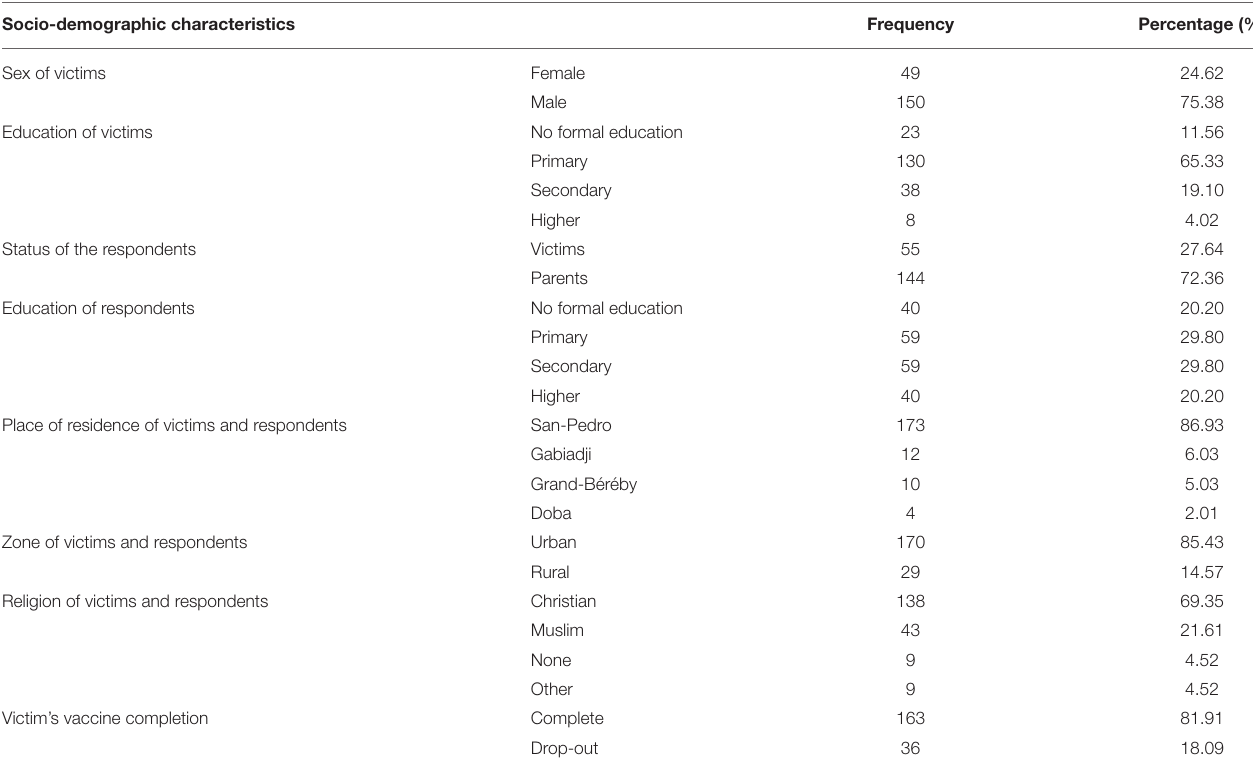
TABLE 1 | Summary of the socio-demographic characteristics of victims only and of all respondents. Socio-demographic